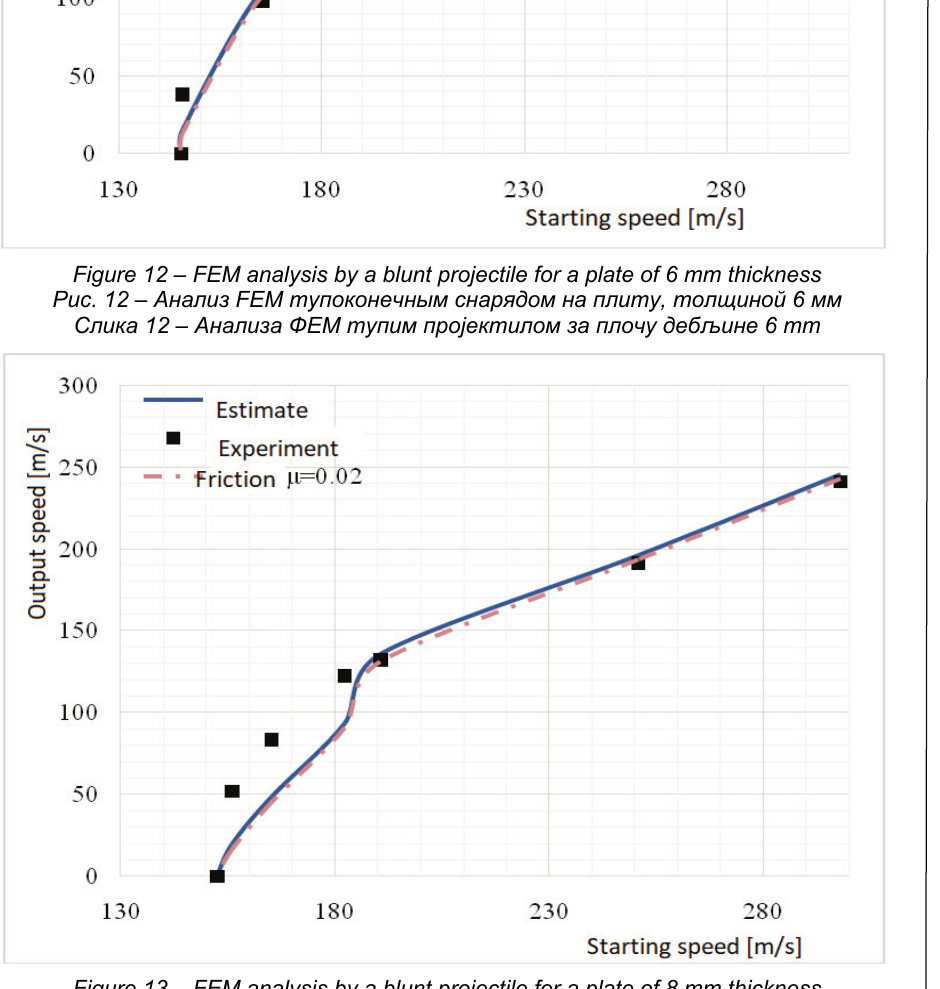
Figure 13 – FEM analysis by a blunt projectile for a plate of 8 mm thickness Рис . 13 – Анализ F Е M тупоконечным снарядом на плиту , толщиной 8